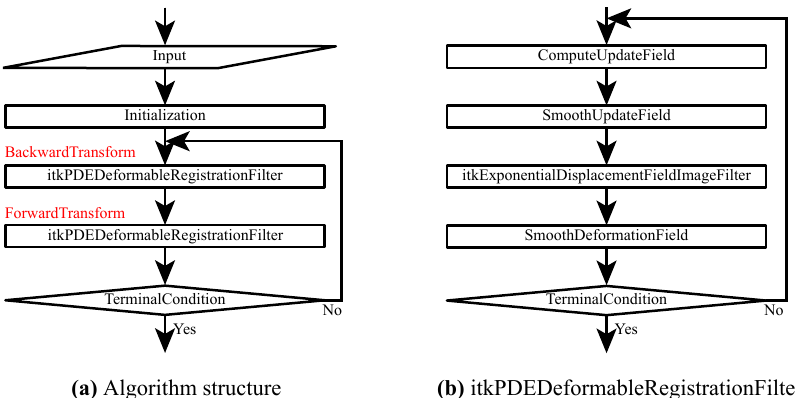
Figure 2. ( a ) The structure of the whole algorithm. ( b ) The structure of itkPDEDeformableRegistra- tionFilter